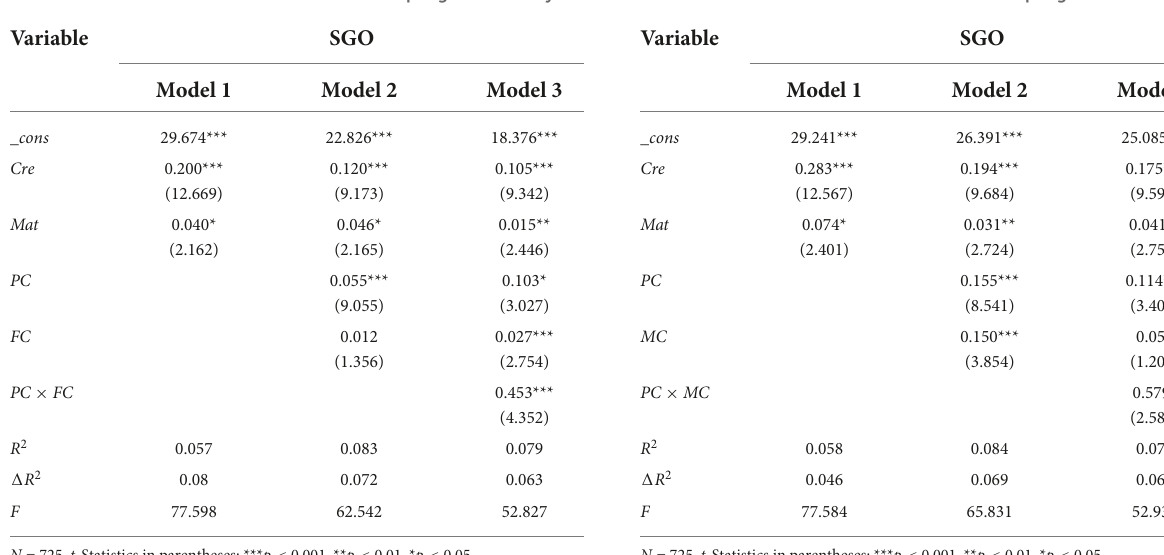
TABLE 6 Government–market dual relationship regression